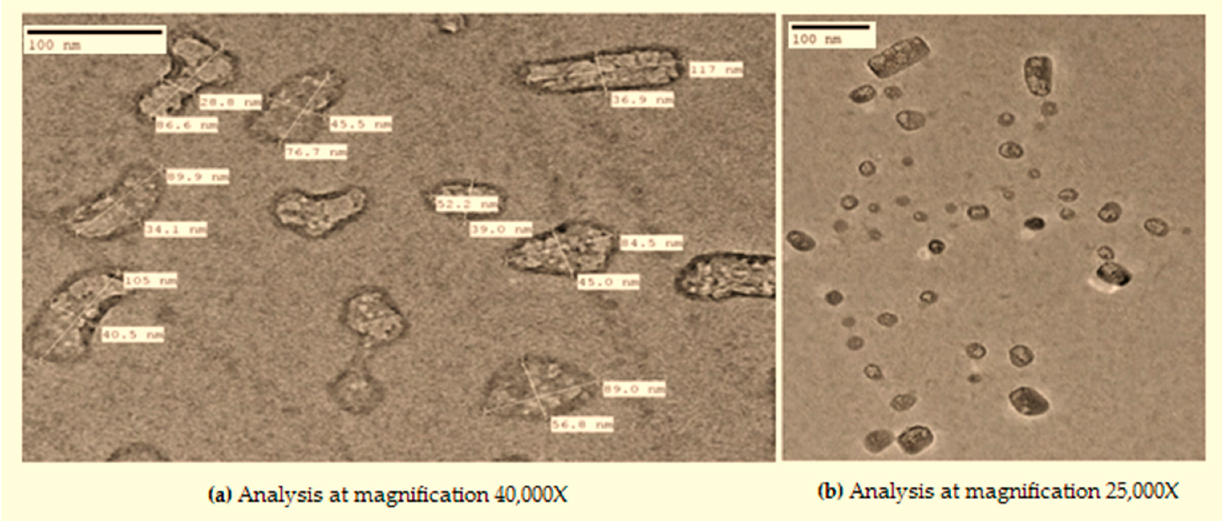
Figure 3. TEM analysis of novel nanocomposite ( a and b representing images at different magnification).